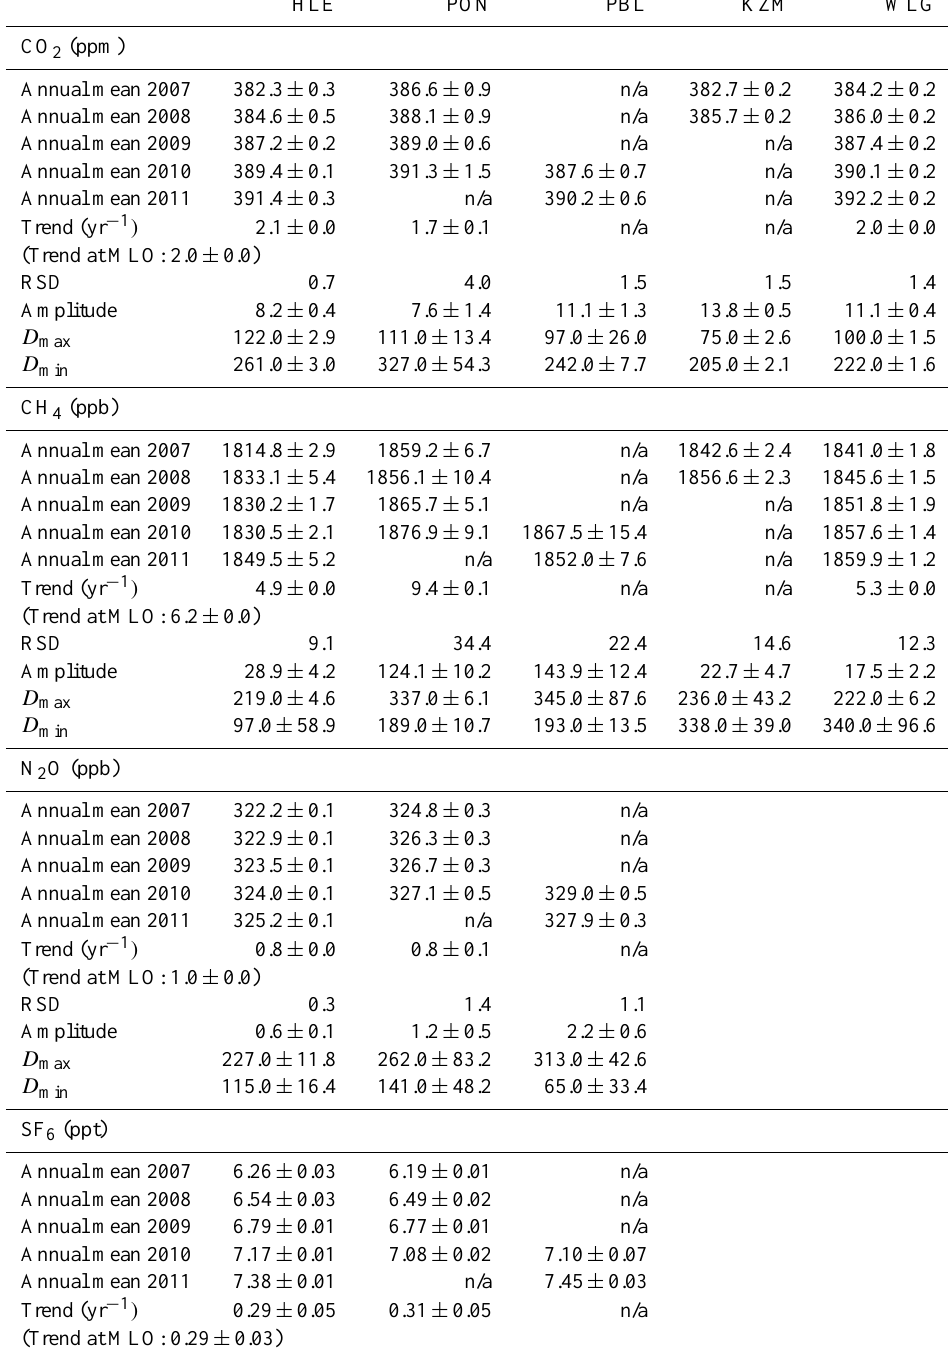
Table 1. Annual mean values, trends, and average peak-to-peak amplitudes of trace gases at HLE, PON, PBL and the two additional NOAA/ESRL stations – KZM and WLG. For each species at each station, the annual mean values and average peak-to-peak amplitude are calculated from the smoothed curve and mean seasonal cycle, respectively. The residual standard deviation (RSD) around the smoothed curve and the Julian days corresponding to the maximum ( D max ) and minimum ( D min ) of the mean seasonal cycle are given as well. Uncer- tainty of each estimate is calculated from 1 SD of 1000 bootstrap replicates. At PON, PBL and KZM, annual mean values and/or trends may not be applicable (n/a) due to data